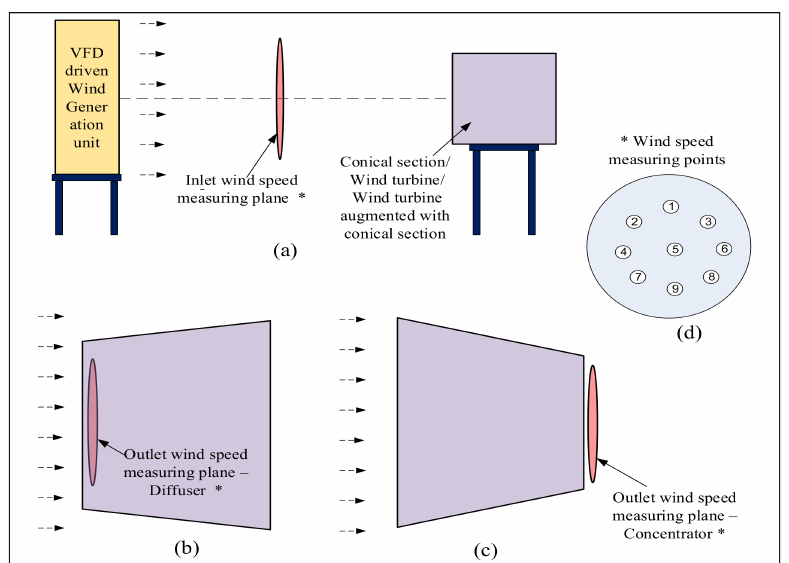
Figure 14. Measurement locations of wind velocity: ( a ) inlet; ( b ) outlet diffuser; ( c ) outlet concentrator. ( d ) Measurement points in the selected